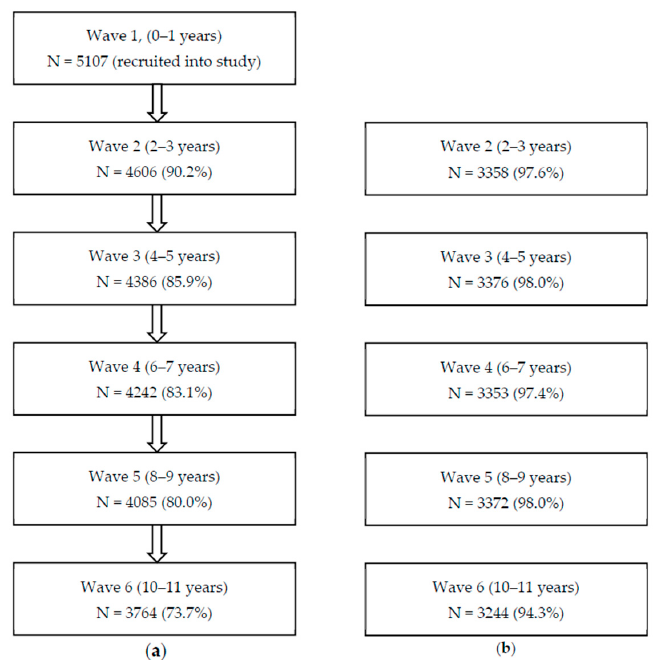
Figure 1. ( a ) Flowchart of cohort attrition for LSAC, ( b ) the number of participants who completed all the oral health questions and were the sample for this study, and percentage of the analytic cohort who had participated every year (n = 3441).